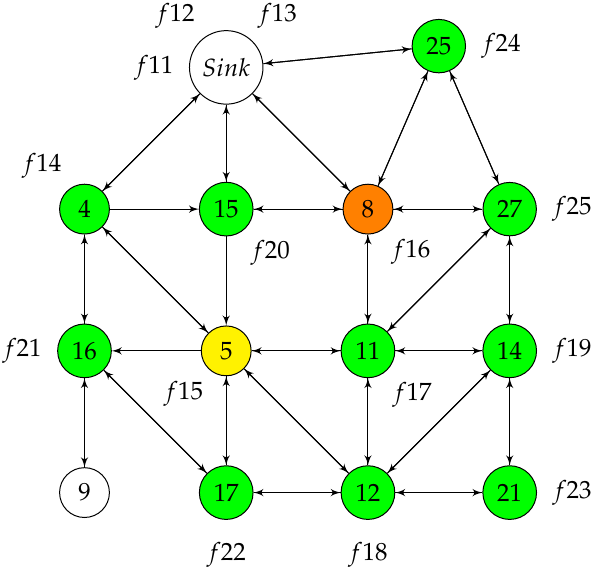
Figure 1. The 1-hop, 2-hop and 3-hop neighbors of node 8 are coloured in green and yellow. The predecessor of node 8 is node 5 coloured in yellow. The reception frequency of each node is labelled. All nodes have one reception channel except the sink, which has